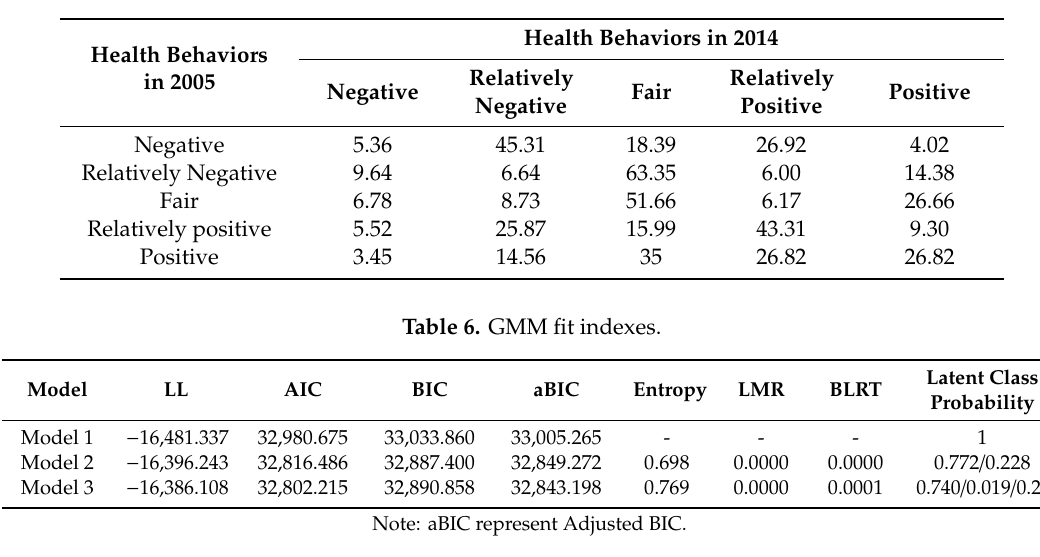
Table 5. Evolution of health behaviors in the Chinese elderly 2005–2014 (%).